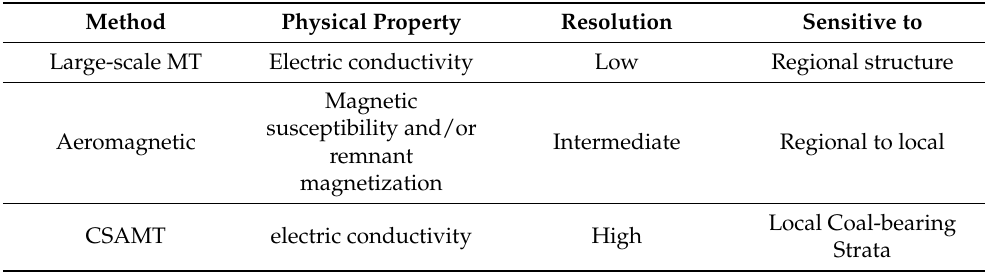
Table 2. Applicability of different geophysical methods at the YJZZ